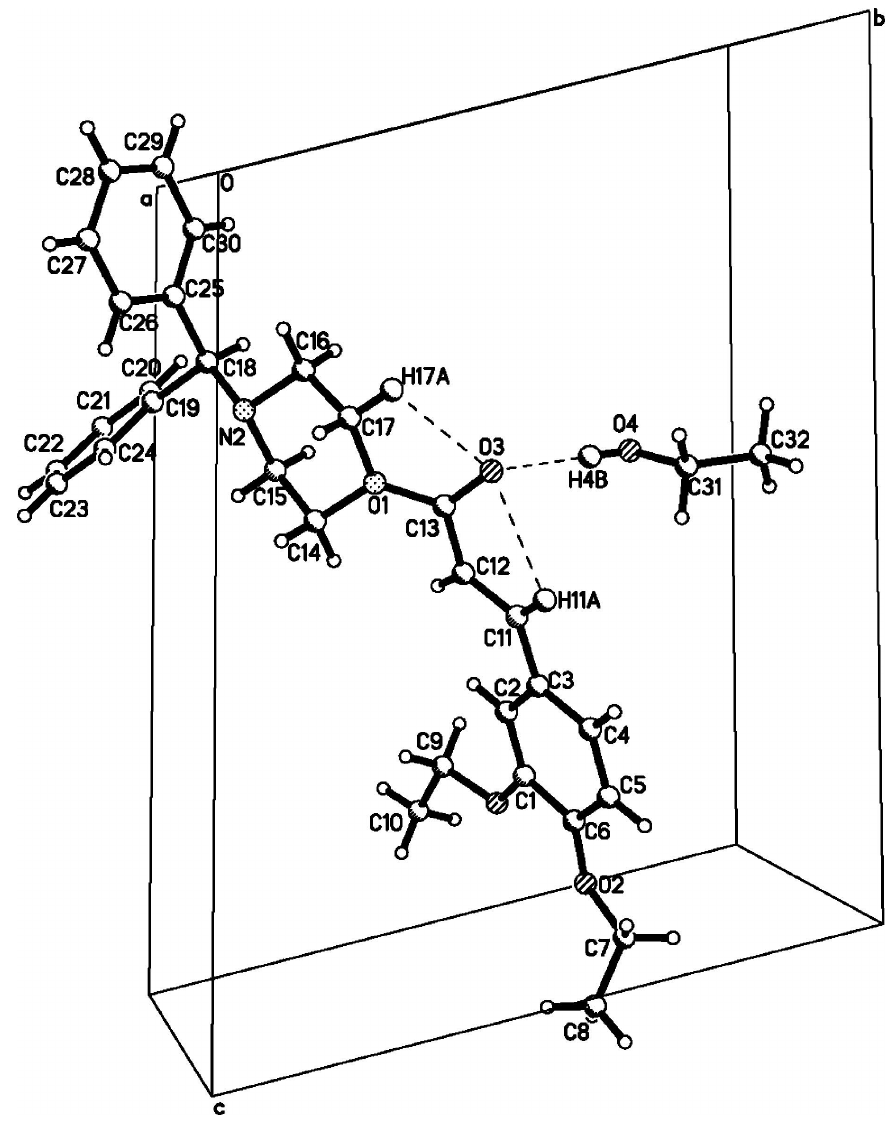
A view of the unit cell of the title compound showing hydrogen